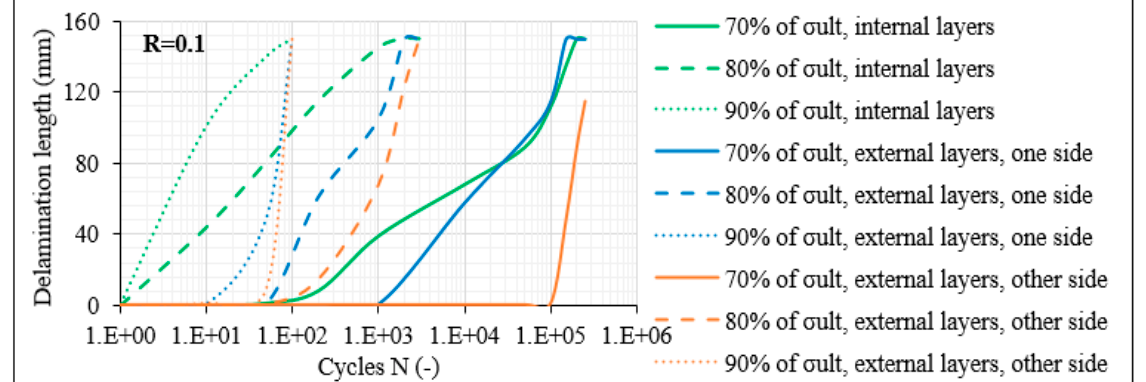
◦ /30 ◦ /0 ◦ / − 30 ◦ ] s laminates for R =